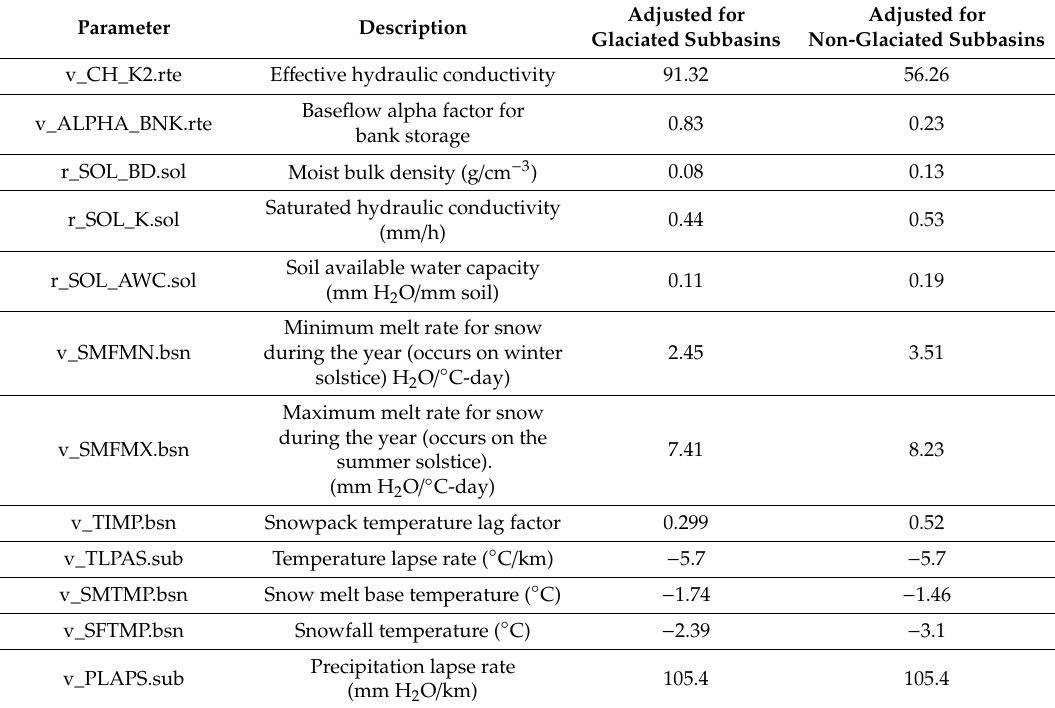
Table 2. Parameters adjusted separately for glaciated and non-glaciated subbasins of the whole Nam Co